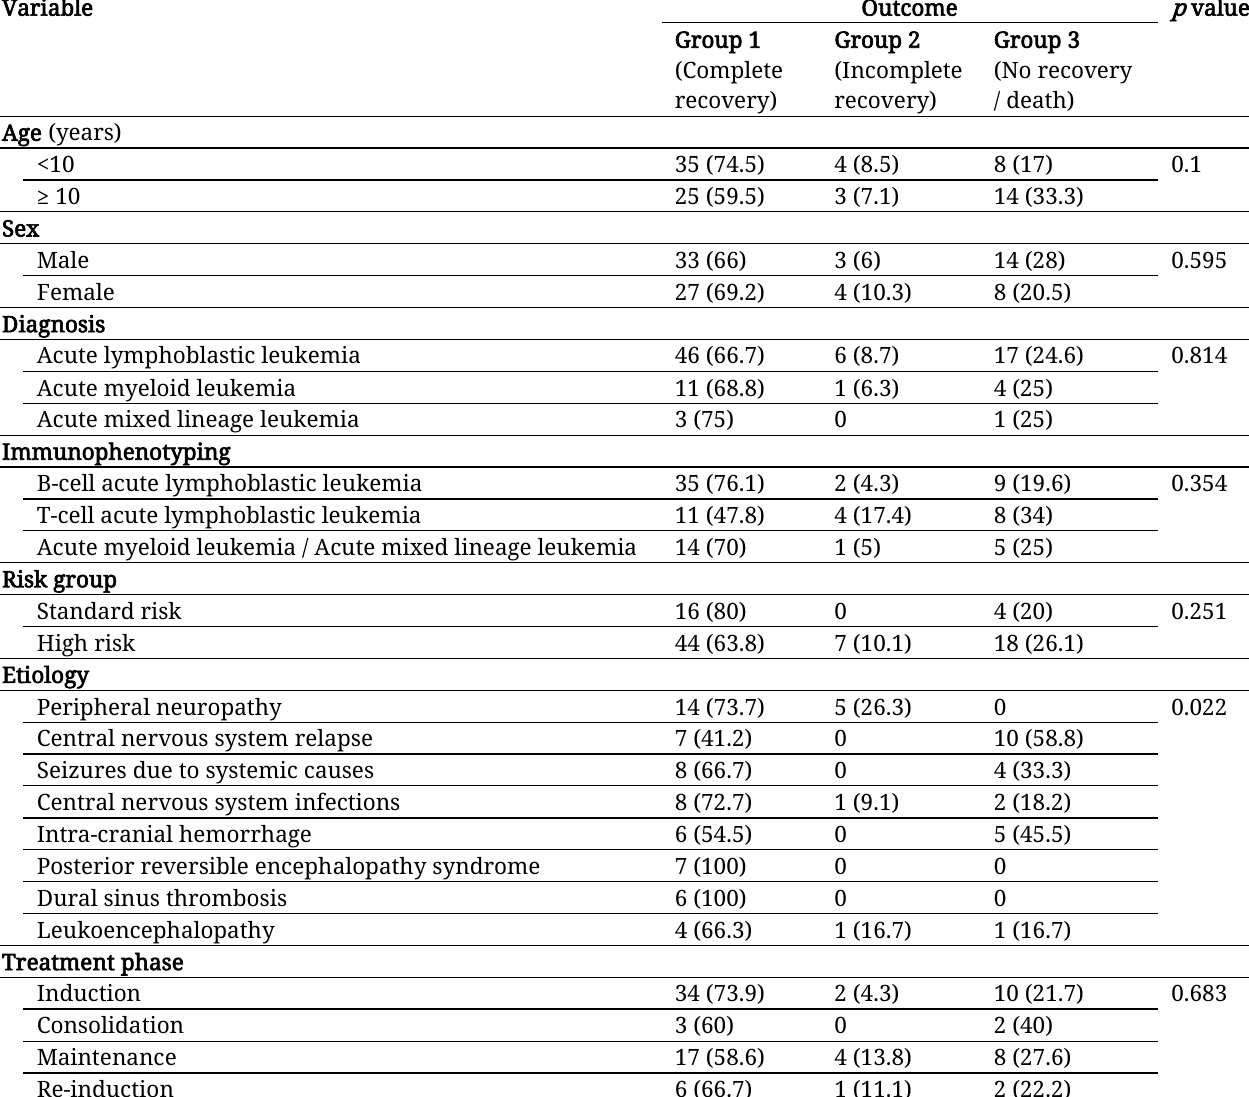
Table 3: The relationship between the outcome of neurological complications and the studied variables